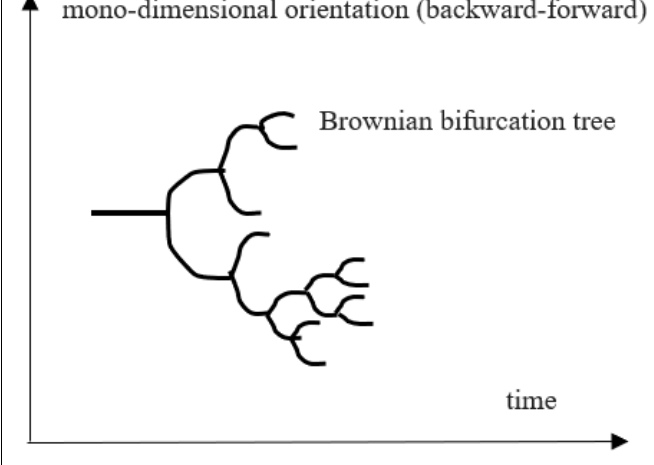
Figure 8: Brownian branching tree of the tracer. Source: Authors,